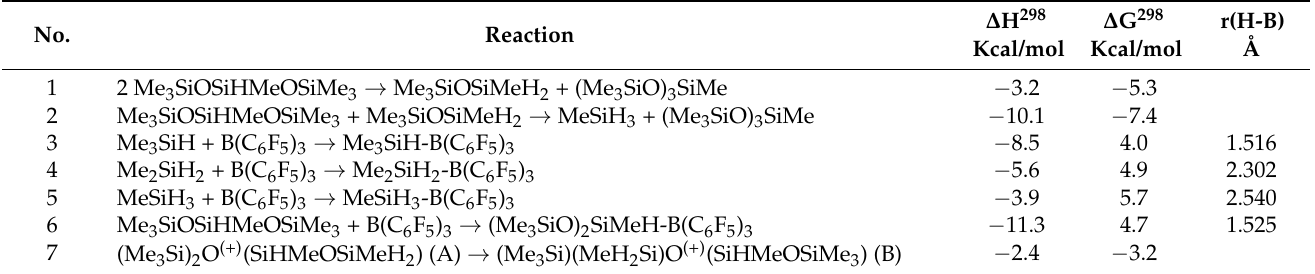
Table 1. Thermodynamic functions and hydrogen–boron bond length of Me n SiH 3-n , n = 1–3, com- plexes with TPFBP and thermodynamic functions of the formation of some siloxonium ions.